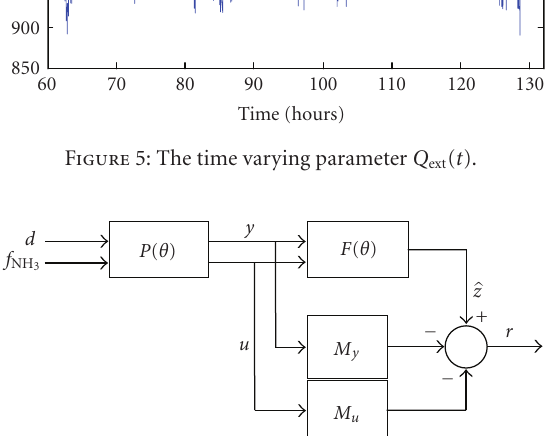
Figure 6: Filter F ( θ ( t )) synthesized